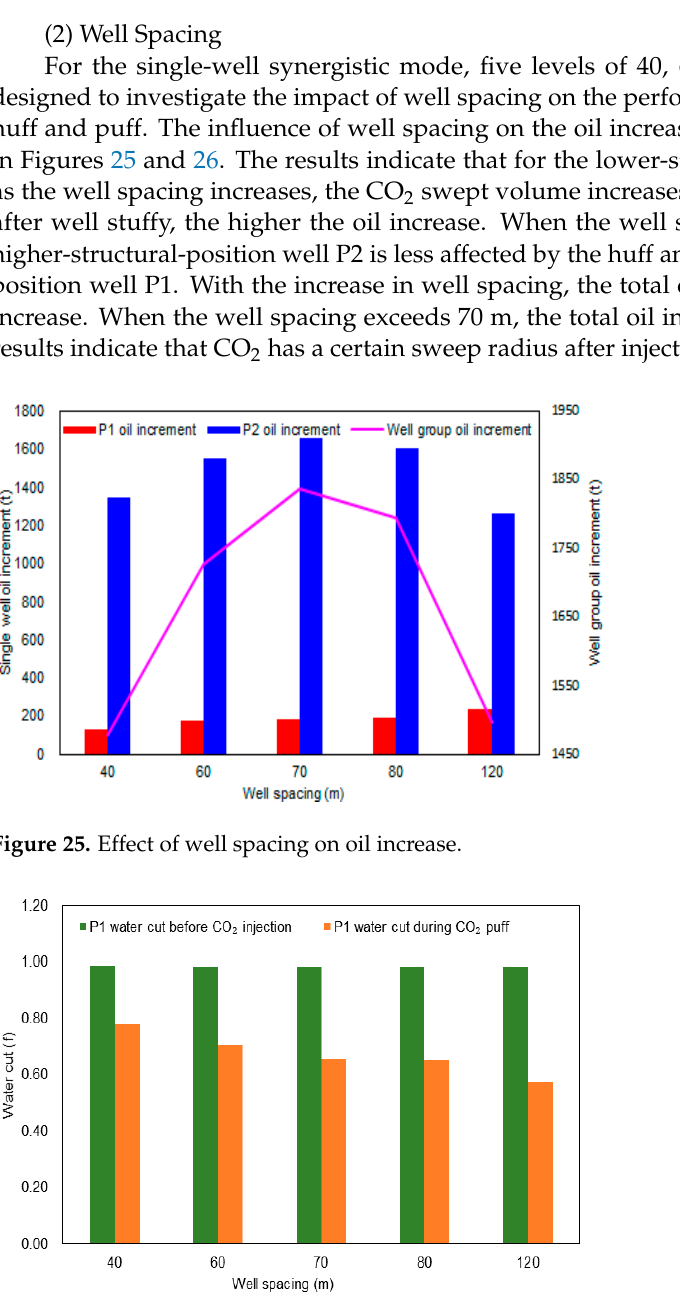
Figure 26. Effect of well spacing on water cut.